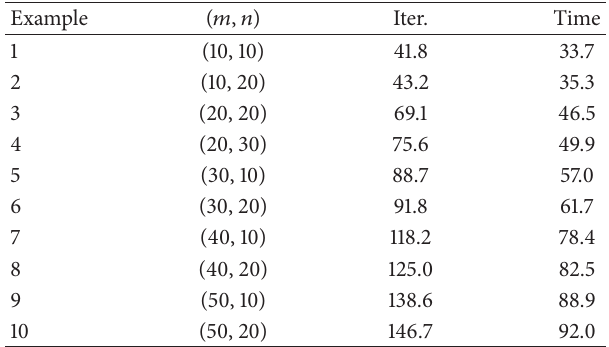
Table 2: Computational results of Example